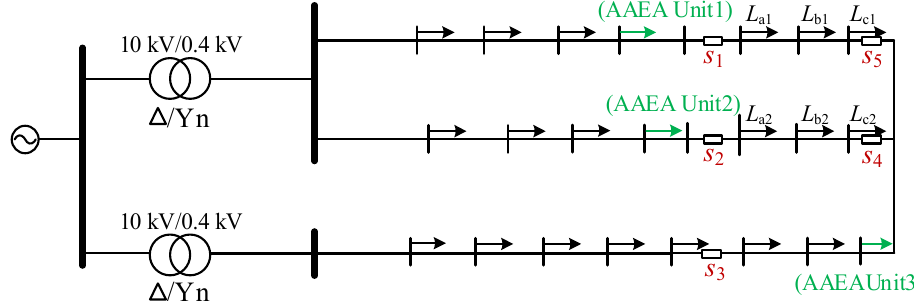
Figure 8. The single-line diagram of LVDN with imbalance mitigation units. As indicated in Figure 8, the coordination control is conducted concerning the im- balance mitigation capacity and location for each AAEA unit and the network topology.